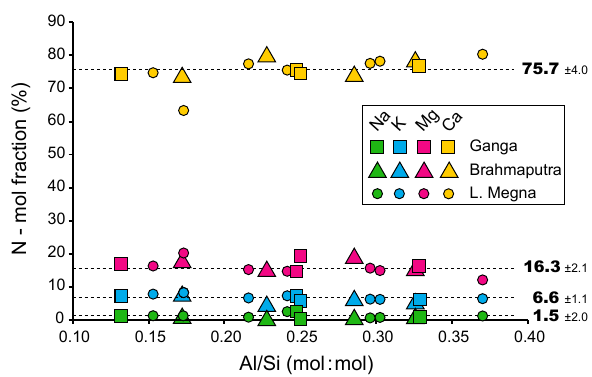
Figure 4. Molar fraction of major cations absorbed to sediments in the Ganga, Brahmaputra and lower Meghna rivers as a function of Al /